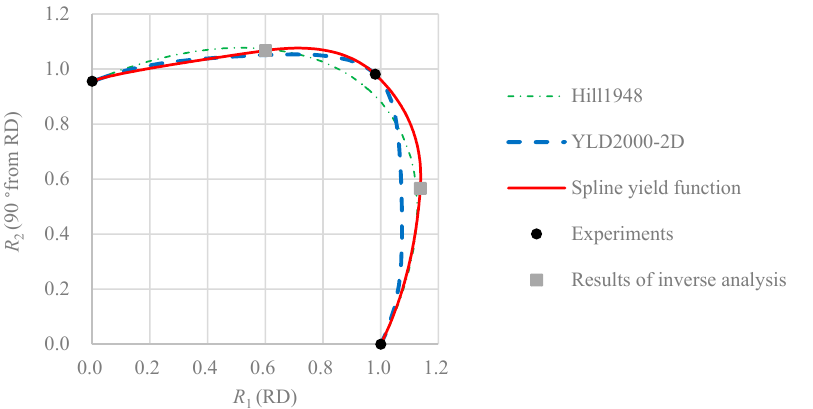
Figure 12. Comparison of the shape of normalized equi-plastic work surface for each yield function.